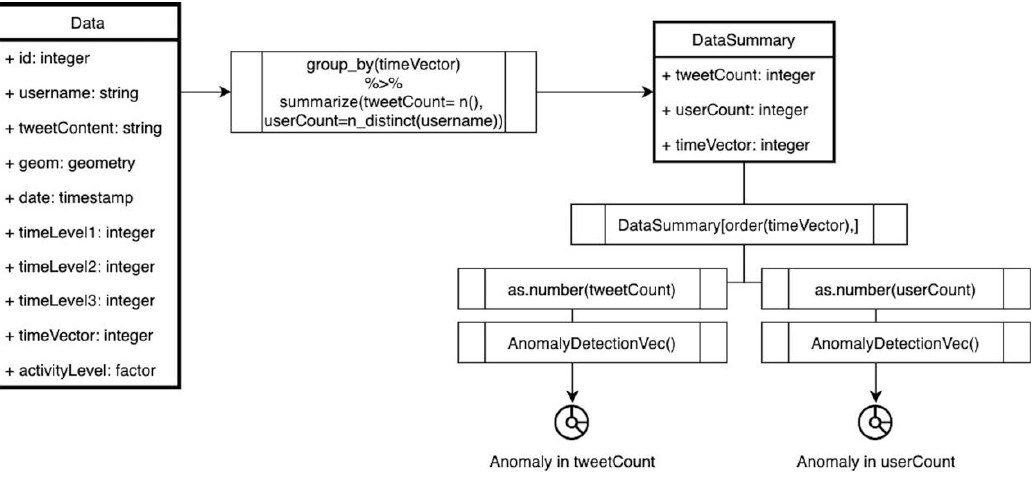
Figure 4. Anomaly Detection Stage 1.